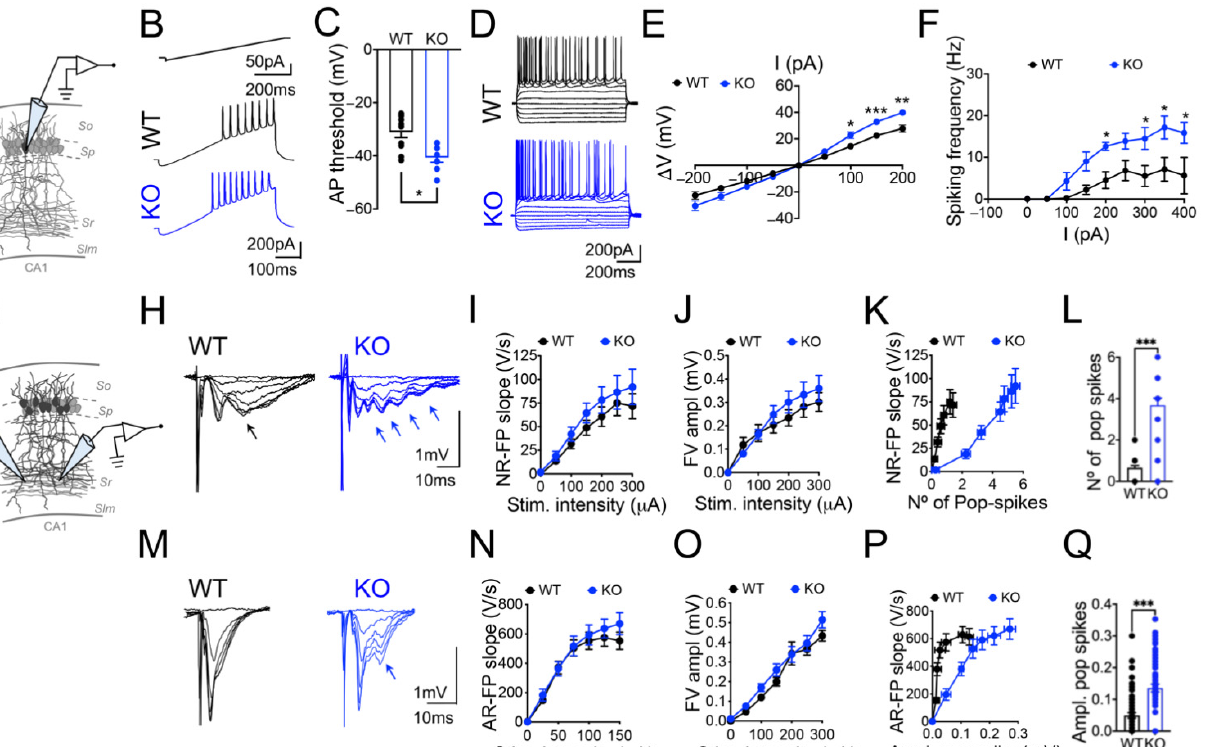
Table 1. Intrinsic passive properties of hippocampal neurons.